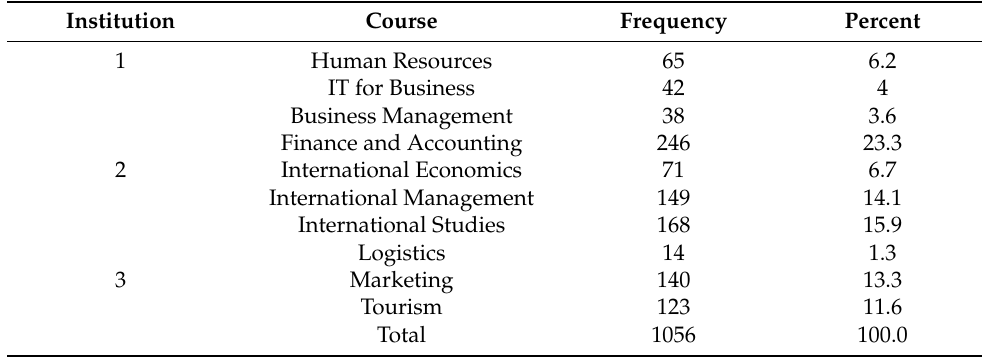
Table 2. Distribution of sample by course